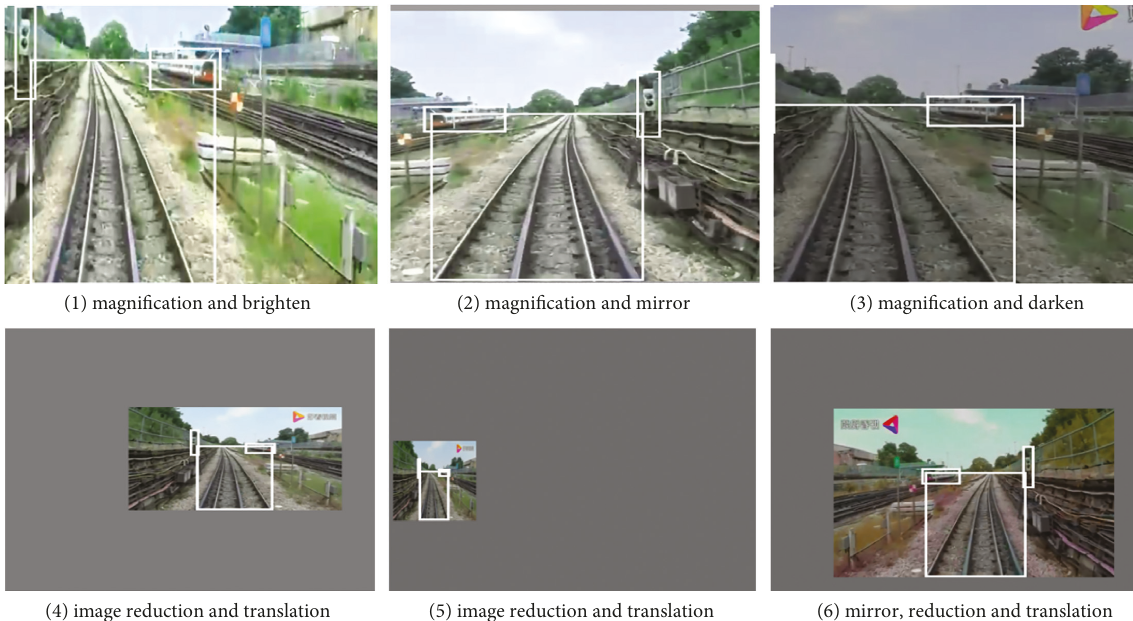
Figure 8: Image after data enhancement. (a) Magnification and brighten, (b) magnification and mirror, (c) magnification and darken, (d) image reduction and translation, (e) image reduction and translation, and (f) mirror, reduction, and translation.